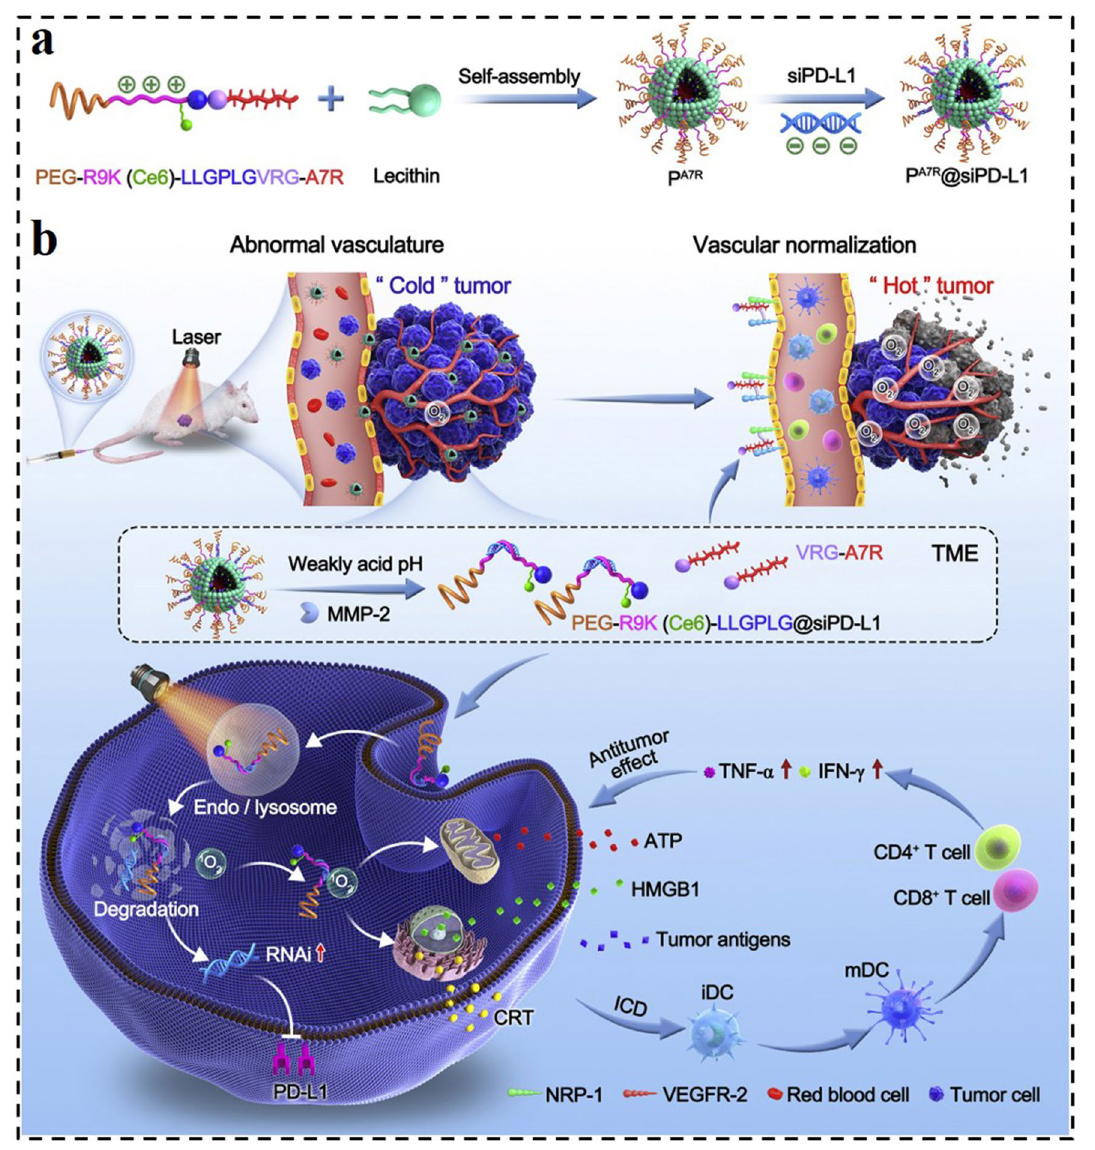
Fig. 14 Illustration of MMP-2-responsive, peptide-assembled micelleplexes for enhanced photoimmunotherapy. a Composition and self-assem- bly process of P A7R @siPD-L1. b Antitumor mechanism of PA7R@siPD-L1-mediated photoimmunotherapy [179]. Copyright 2022,